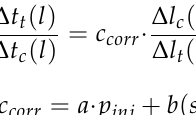
Figure 13. Comparison of measured aspect ratios of all tool sections.